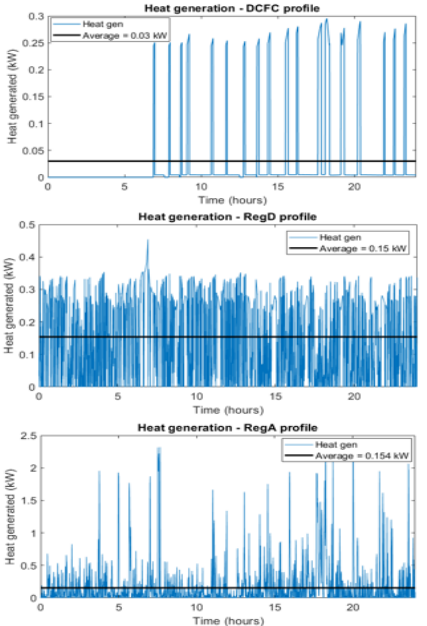
Figure 11. Heat generation on the pack level with power profile normalized by the critical number of batteries for each application.